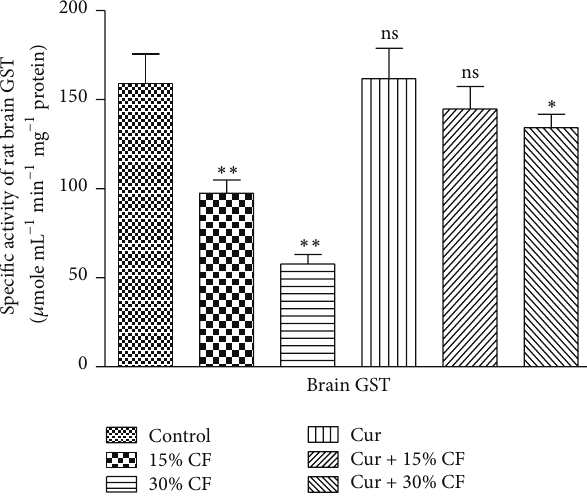
exposure to 15% LD 50 of carbofuran caused significant inhi-